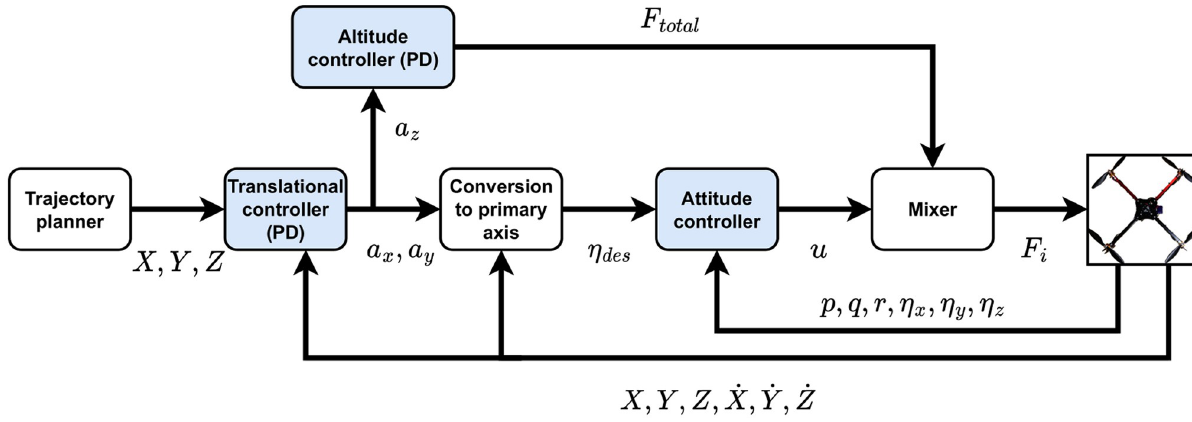
Fig 2. Cascaded control architecture in case of propeller